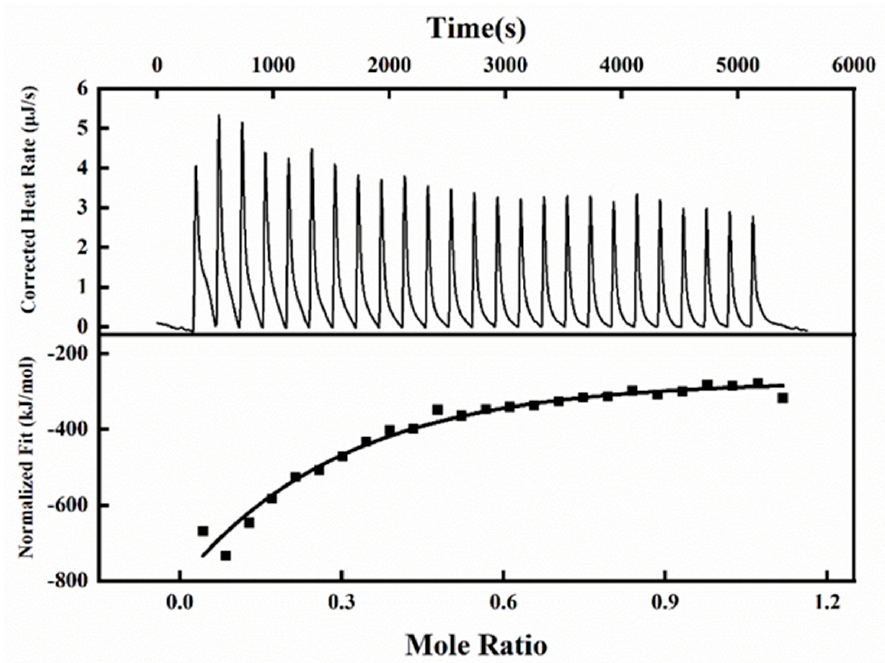
Figure 3. ITC thermograms for the titration of Mal − mPEG5000 with SPA.